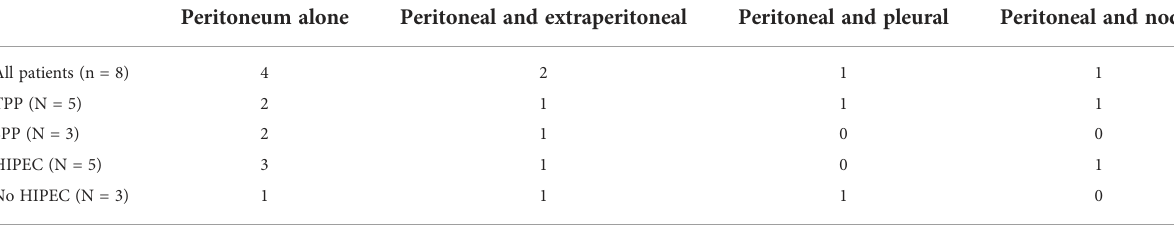
TABLE 7 Sites of recurrence in 8 patients who developed platinum resistant recurrence. Peritoneum alone Peritoneal and extraperitoneal Peritoneal and pleural Peritoneal and nodal All patients (n = 8) 4 2 1